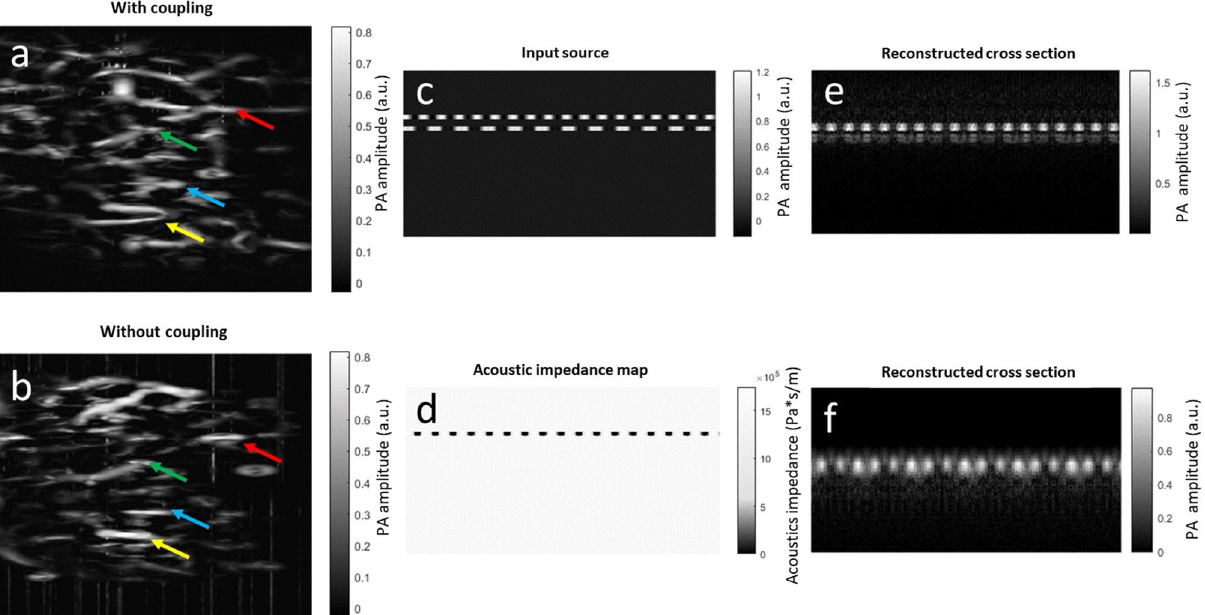
Figure 7. Extraction of vascular structure in dry coupling. ( a ) Vessel-enhanced MAP image of the fingertip with gel coupling. ( b ) Vessel-enhanced MAP image of the fingertip witout gel coupling. ( c ) Distribution